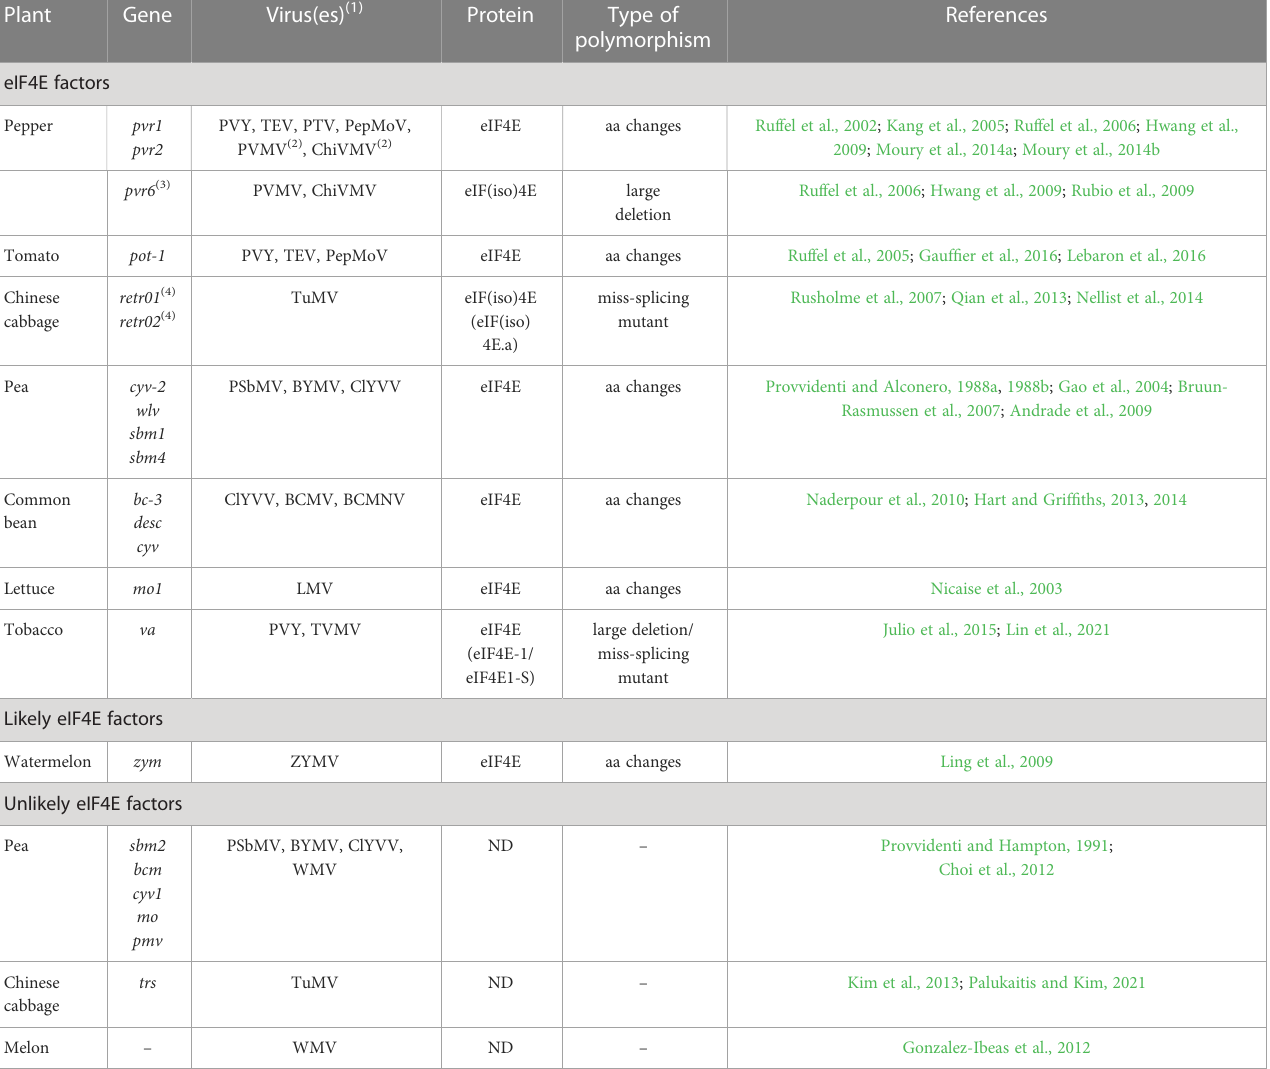
TABLE 1 Recessive genes conferring resistance against potyviruses to crop plants.